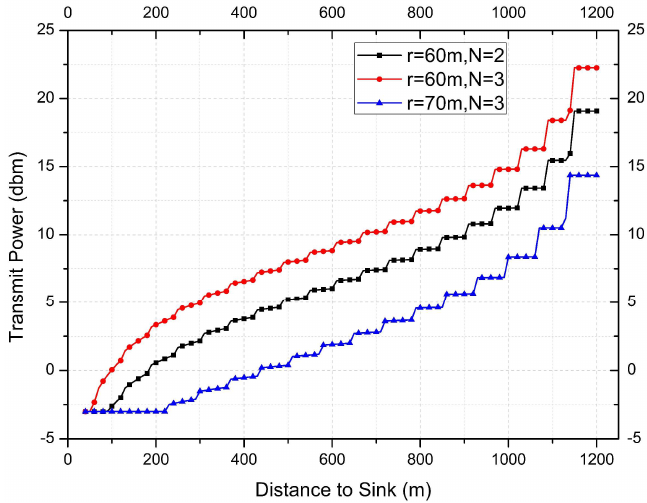
Figure 14. Transmit power of node at different distance in COOR(R)